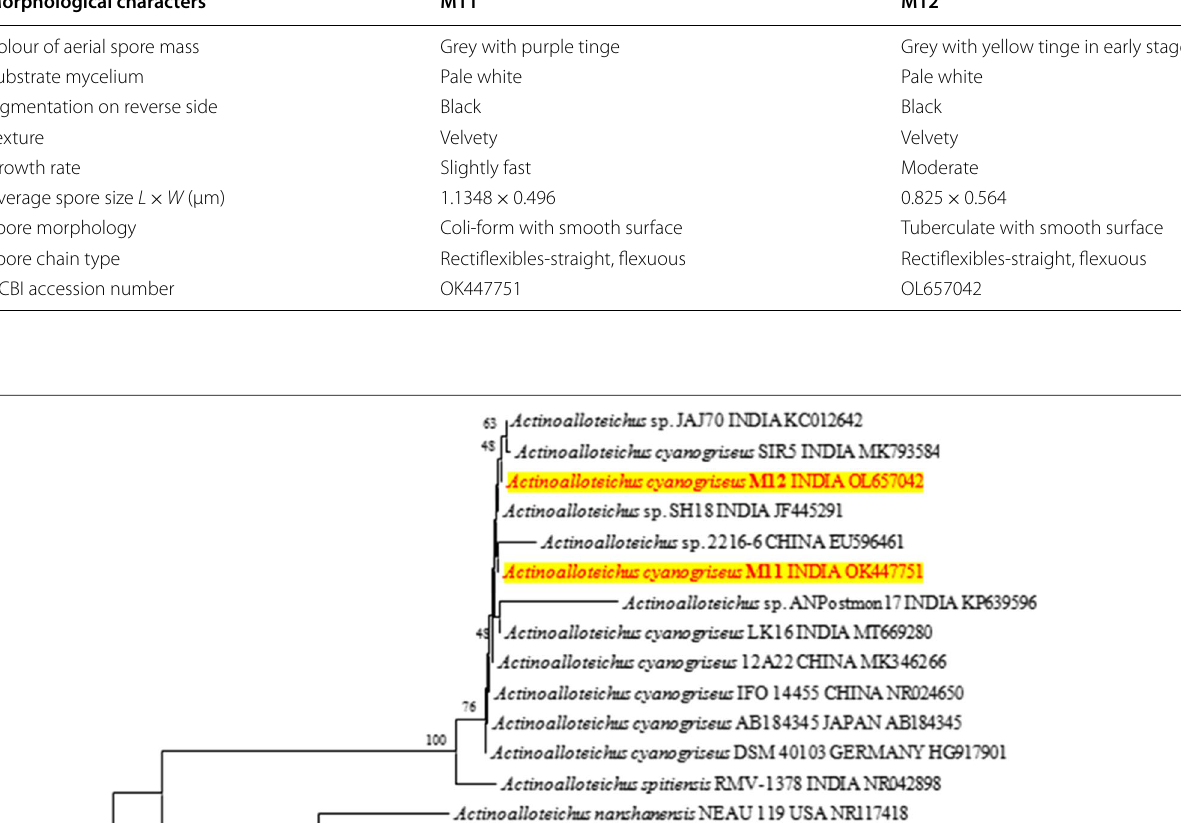
Table 2 Morphological characterization of Actinoalloteichus cyanogriseus isolates obtained from mulberry rhizosphere Morphological characters